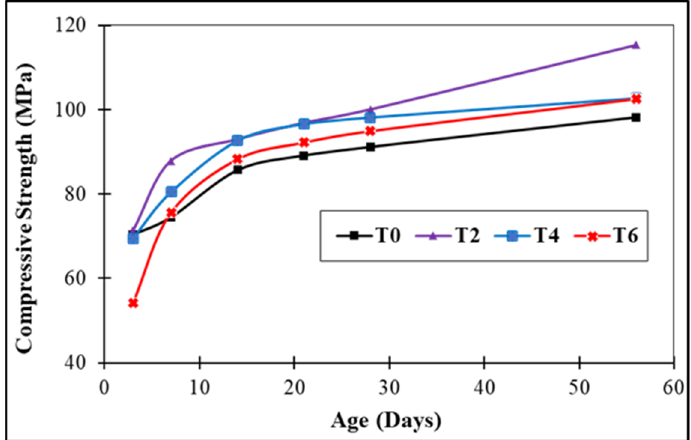
Figure 4. Compressive strength of mortar composites with varying fly ash and silica fume content.